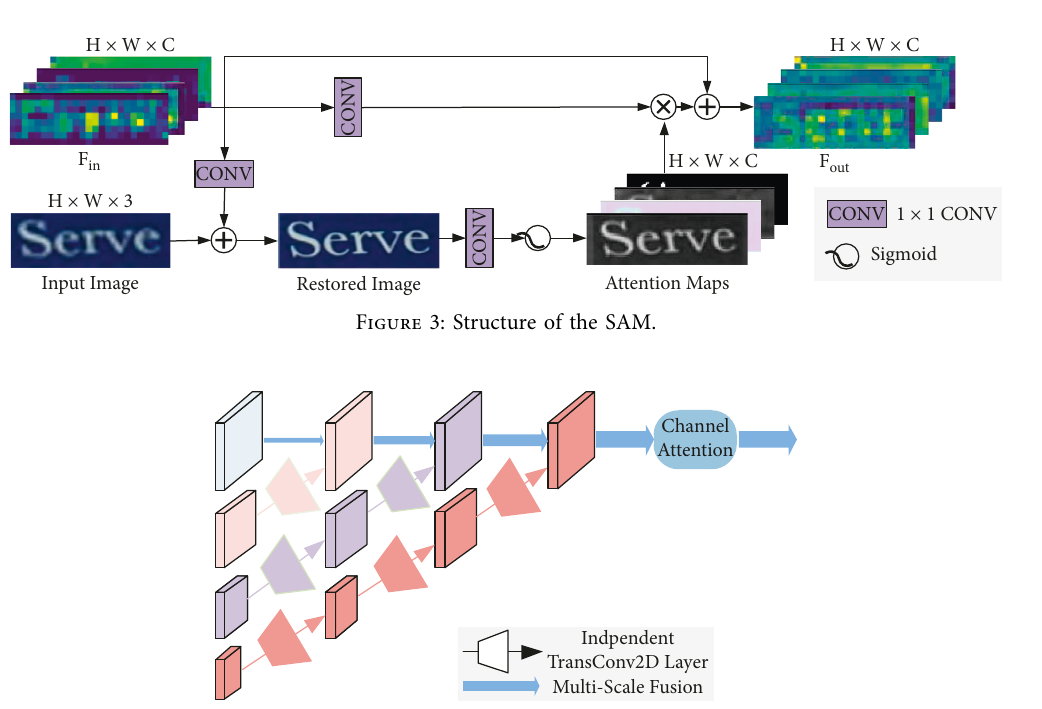
Figure 2: Structure of the encoder module.